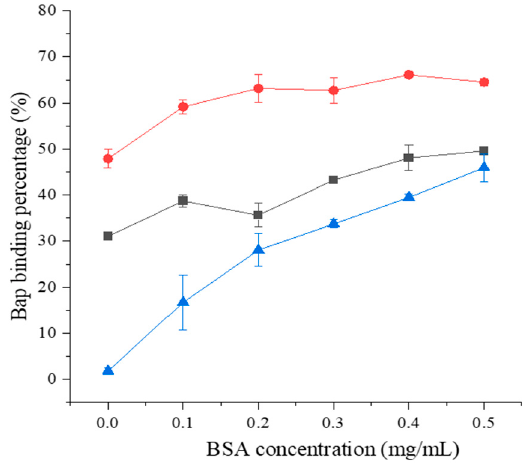
Figure 1. The BaP-binding ability of Lactobacillus –BSA. Control, 121, and ML32.